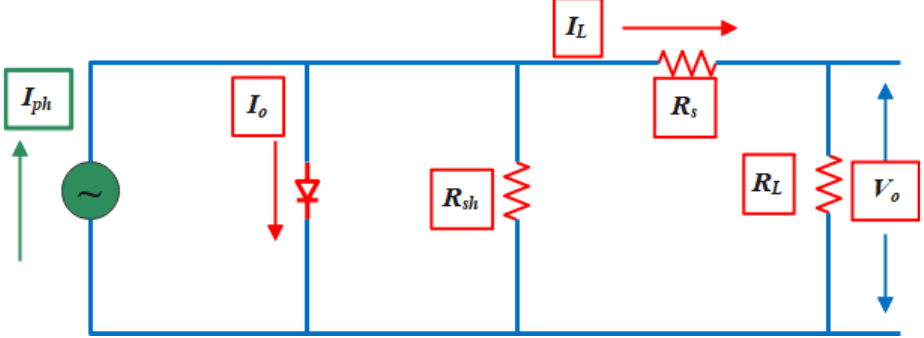
Figure 4. Mathematical model of photovoltaic cells.